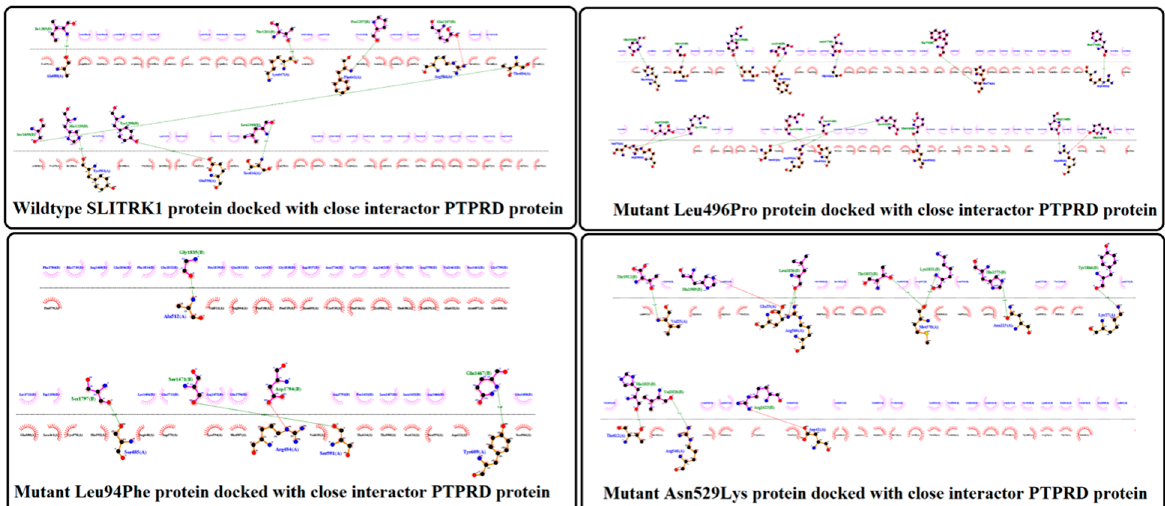
Figure 7. Protein–Protein docking of the SLITRK1 wild type and variants with their close interactor PTPRD.